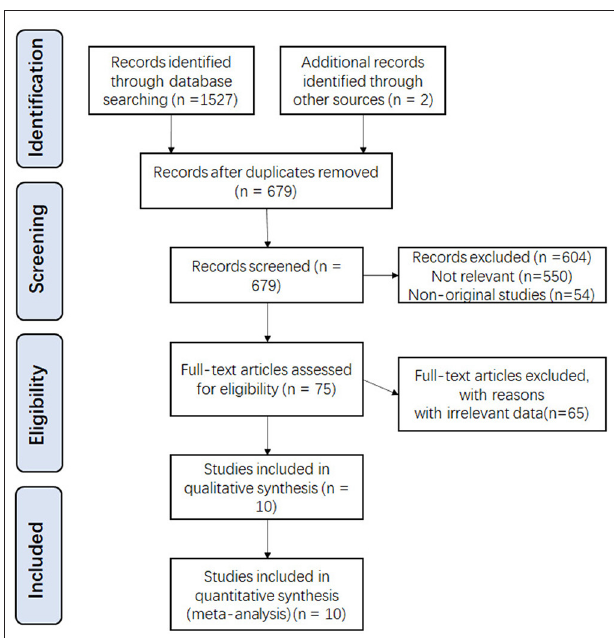
FIGURE 1 | Flow chart of the selection